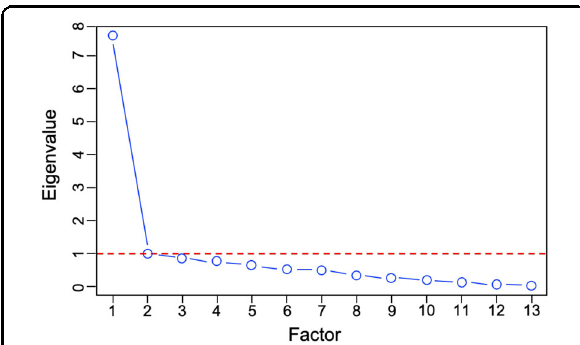
Fig. 1 Exploratory factor analysis identi fi es a single trauma exposure factor. Exploratory factor analysis was conducted with 13 trauma items. The number of factors is plotted along the x -axis while the eigenvalues are plotted along the y -axis. The screen plot of the results indicates a steep decrease ( “ elbow ” ) at two factors, suggesting that the trauma items are represented by single